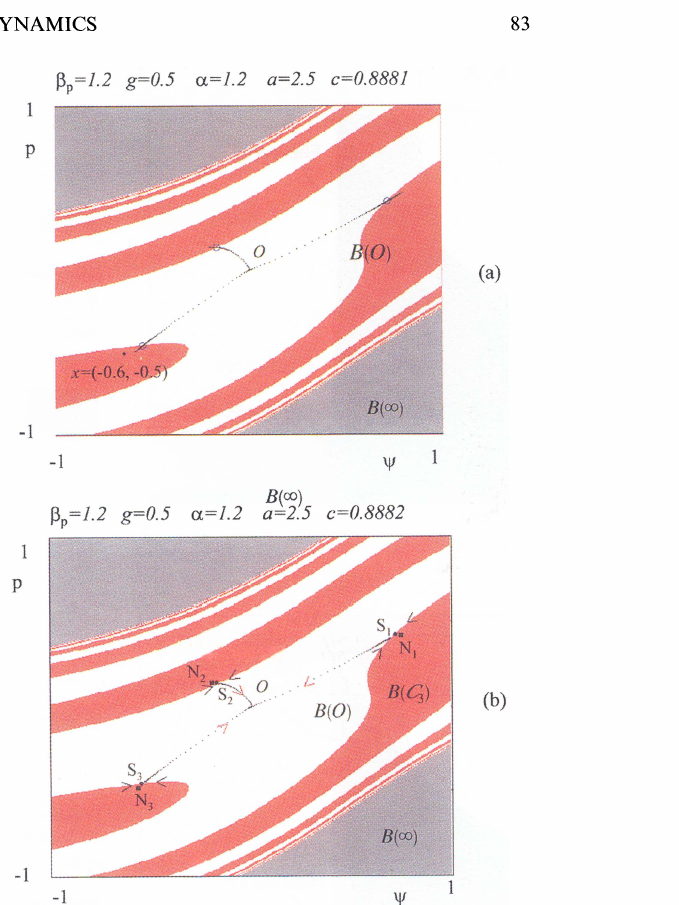
FIGURE 7 /3p= 1.2, g-0.5, c= 1.2, a--2.5. In (a), for c=0.8881, the fixed point is the only attractor, with a wide and connected basin, in which the white region is given by the points whose trajectories enter a neighbourhood of O of radius r--0.001 in less than 300 iterations, while the red area is made up of the points which converge to O more slowly. A trajectory starting in the red region moves cyclically for a long time inside the three balls, before converging to O (inter- mittency) and this behaviour anticipates the appearance, via saddle-node bifurcation, of a 3-cycle attracting node {N1, N2, N3} and a 3-cycle saddle {$1, $2, $3}, which are represented in (b) for c--0.8882. The red area in (b) represents the basin of the attracting 3-cycle C3 {N, N2, N3 }, while the white area is the basin of the attracting fixed point O. The basin of the attracting node C3 may be subdivided further into three different regions, by considering the periodic points as fixed points of the map T 3, as shown in (c), obtained for c--0.95. From the same figure we see that the competing attracting set C3 attracts now most of the points with bounded trajectories. (See Color Plate II.)